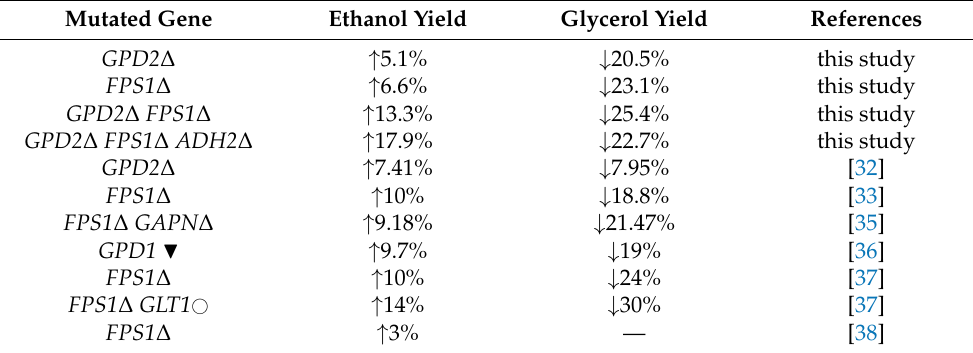
Table 3. The yields of ethanol and glycerol in S. cerevisiae engineering strains.